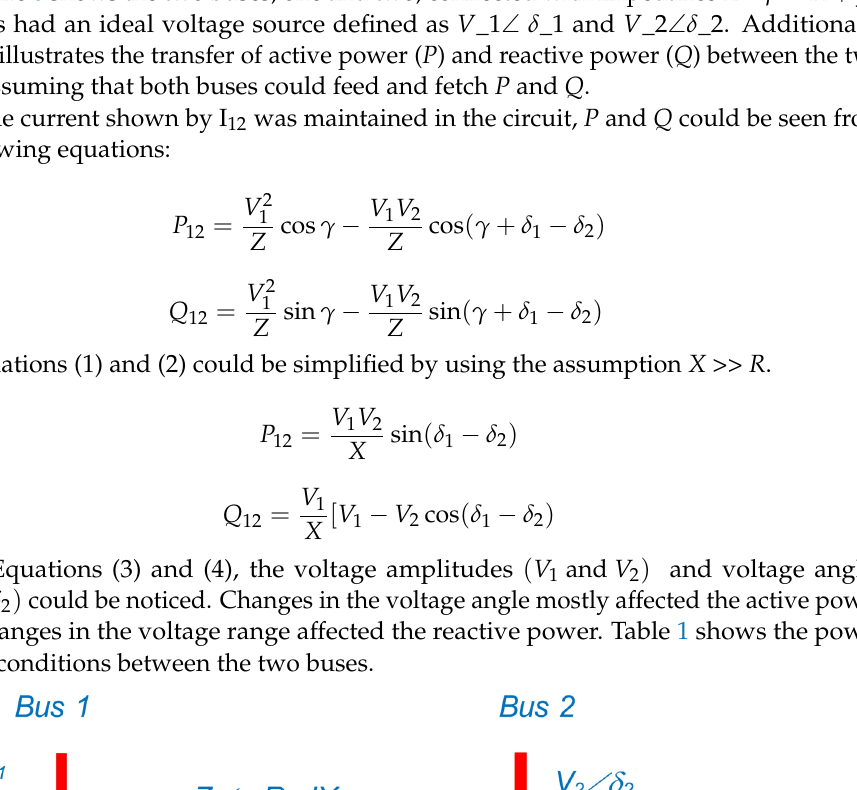
Figure 5. Current and voltage waveforms in the proposed CC/RCC are a charging scheme.